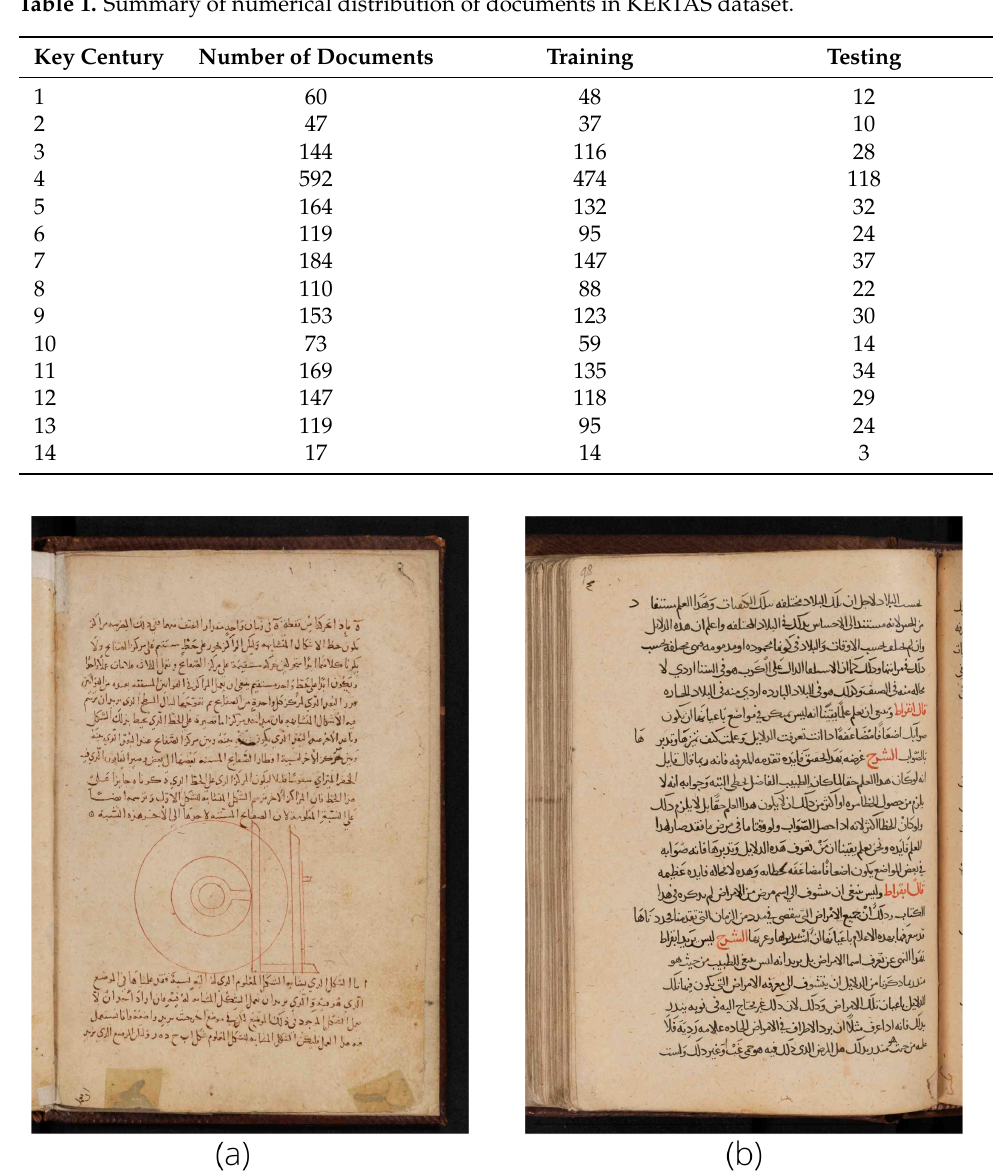
Table 1. Summary of numerical distribution of documents in KERTAS dataset.